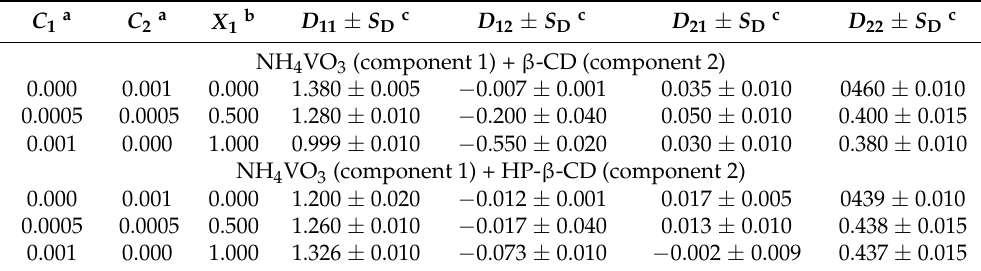
Table 2. Experimental ternary diffusion coefficients ( D 11 , D 12 , D 21 , and D 22 ) of aqueous NH 4 VO 3 ( C 1 ) + CDs ( C 2 ) solutions and at T = 25.00 ◦ C and P = 101.3